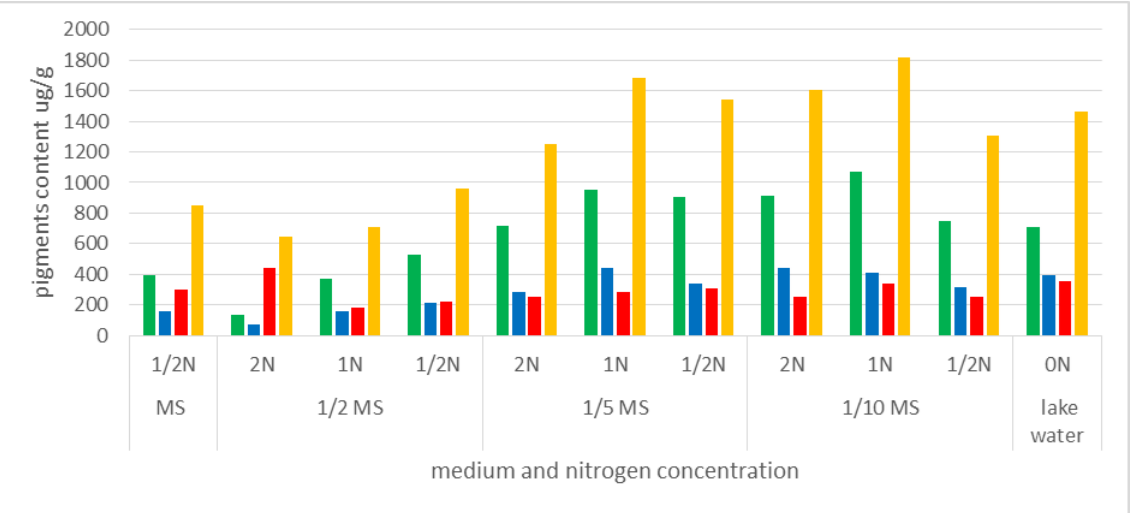
Figure 9. Content of photosynthetic pigments in Aldrovanda vesiculosa plant material from in vitro cultivation and from a natural site (Lake Łukie). MS— Murashige and Skoog medium formulation, 1/2N, 1/5MS, 1/10MS — mineral salts diluted to 1/2, 1/5, 1/10; N — content of nitrogen compounds NH 4 NO 3 and KNO 3 with concentration doubled (2N), unchanged (1N) or diluted twice (1/2N); ON — natural water lake. Green represents chlorophyll a content, blue — chlorophyll b , red — carote- noids, and yellow — sum of pigments.